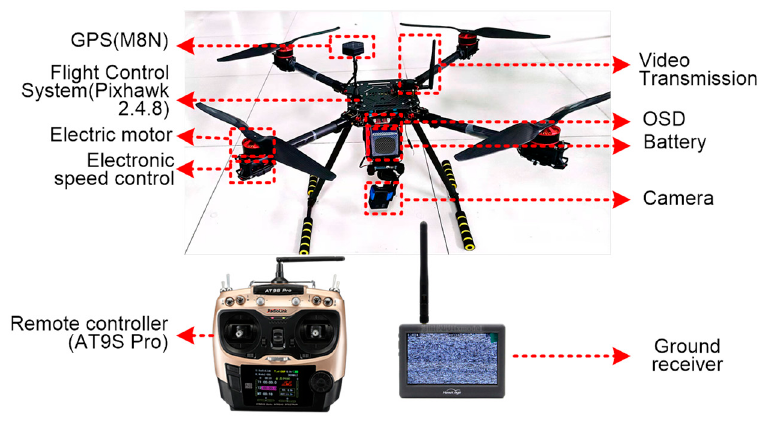
Figure 5. Assembled FPCS and part